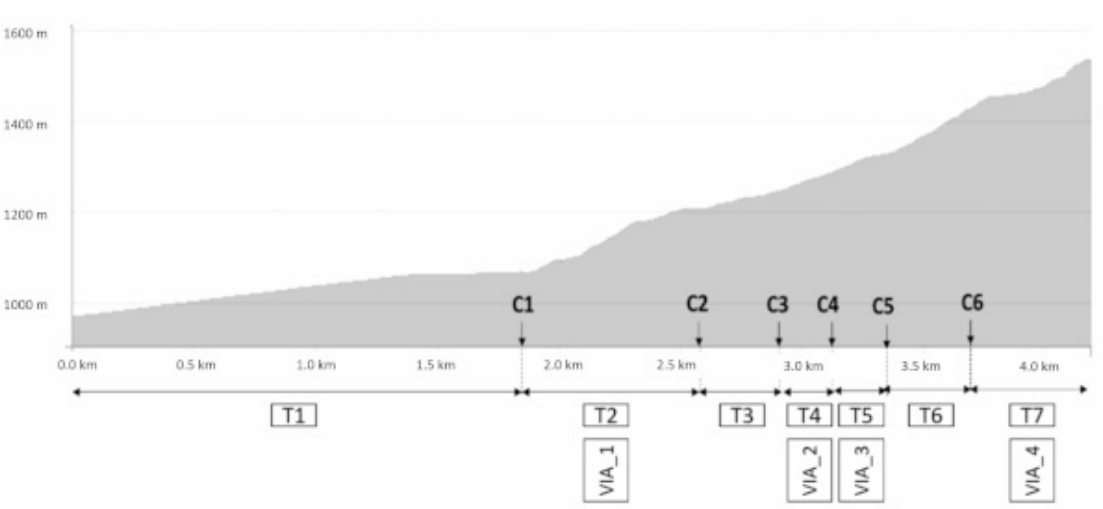
Figure 1. Track of the race with control points (C1–C6), sections (T1–T7), and vertical impact acceleration (VIA_1-VIA_4). The measurements of the skeletal muscle tone and stiffness were taken in a tent provided by the organizer, near the race start